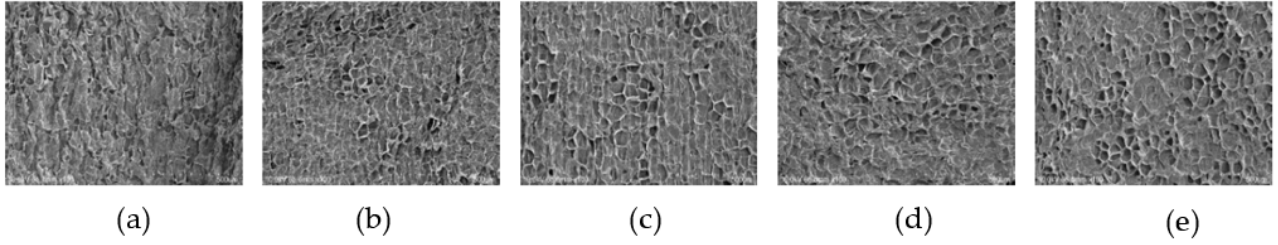
Figure 4. SEM images of carrot with different strengths of PEF pretreatment after rehydration. ( a ) Control: untreated; ( b ) 1.0 kV/cm: carrot treated with PEF 1.0 kV/cm, ( c ) 1.5 kV/cm: carrot treated with PEF 1.5 kV/cm; ( d ) 2.0 kV/cm: carrot treated with PEF 2.0 kV/cm; ( e ) 2.5 kV/cm: carrot treated with PEF 2.5 kV/cm.